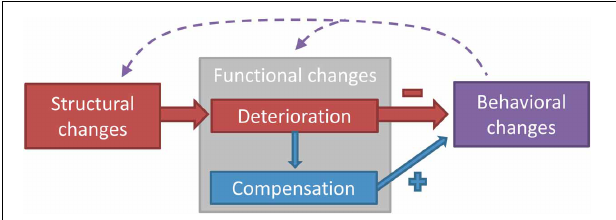
FIGURE 1 | A classification model of the different domains of age-related changes in the neuromotor system controlling postural and manual tasks. Three domains can be distinguished: structural changes, functional changes, and behavioral changes. Structural changes refer to the degeneration of brain or nerve structures with aging, whereas functional changes refer to the age-related modification in how these structures operate in the act of motor control. Behavioral changes denote the changes in performance on the motor task, which can be both a postural or a manual task. Functional changes can be divided into deterioration (as a direct result of the structural changes) and compensation (changes in function to counteract the deterioration). Structural degeneration causes functional deterioration (Rivner et al., 2001), which triggers the need for functional compensation (Mattay et al., 2002). Functional deterioration has a negative impact on performance (Nardone et al., 1995), whereas functional compensation has a positive impact (Mattay et al., 2002). The dashed arrows acknowledge the influence that acute or chronic behavioral changes, i.e., intervention or differences in lifestyle, have on structure and function of the neuromotor system (Taube et al., 2007; Rovio et al., 2010; McGregor et al., 2011). The model can be used in future studies to systematically examine the structure-function-behavior link in the aging neuromotor system and could also be applied to other fields of